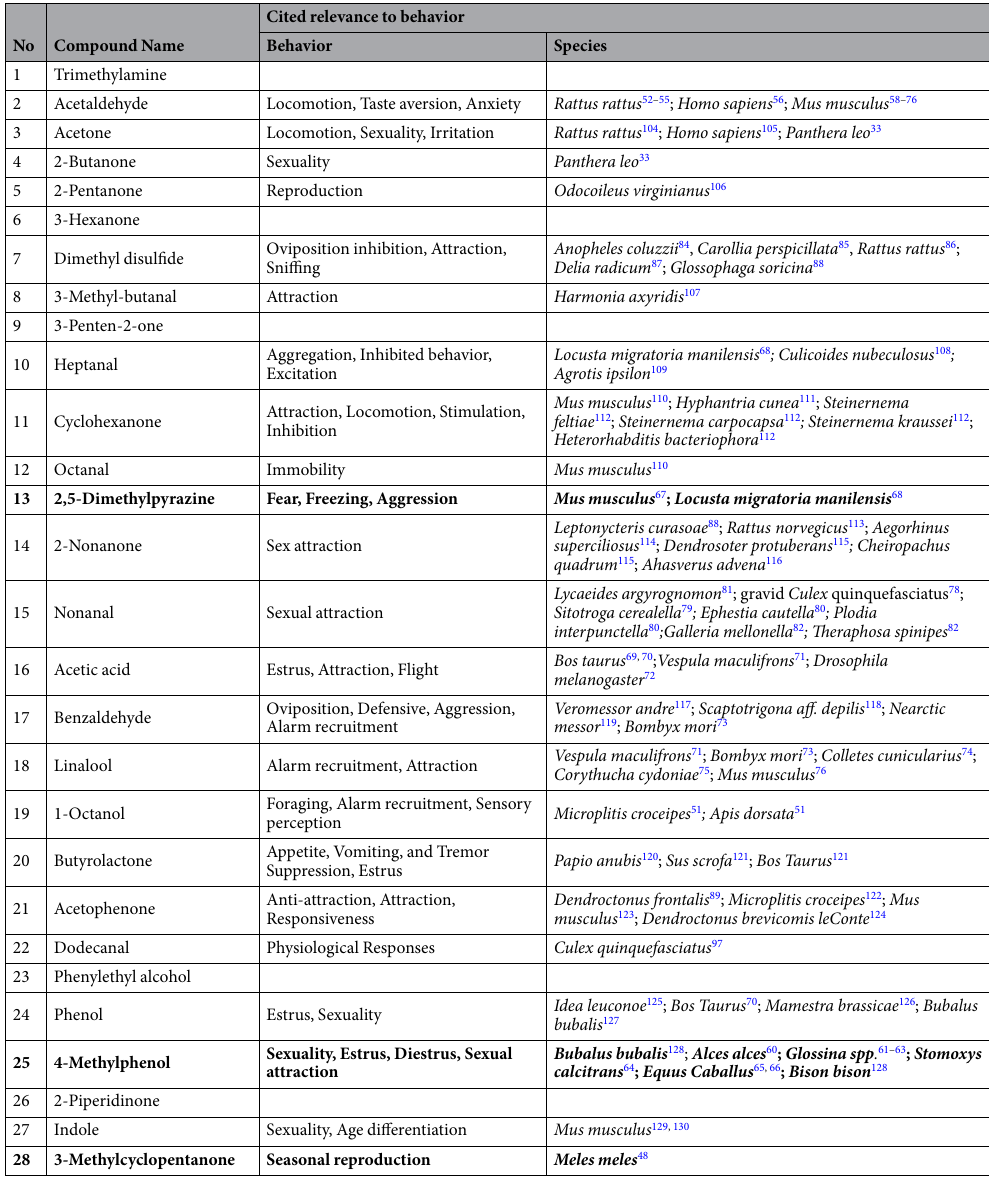
Table 2. VOC composition of P. leo marking fluid and published reports of biological role. Bold font signifies compounds responsible for the characteristic odor of lion MF. * Superscripted numbers correspond to the reference